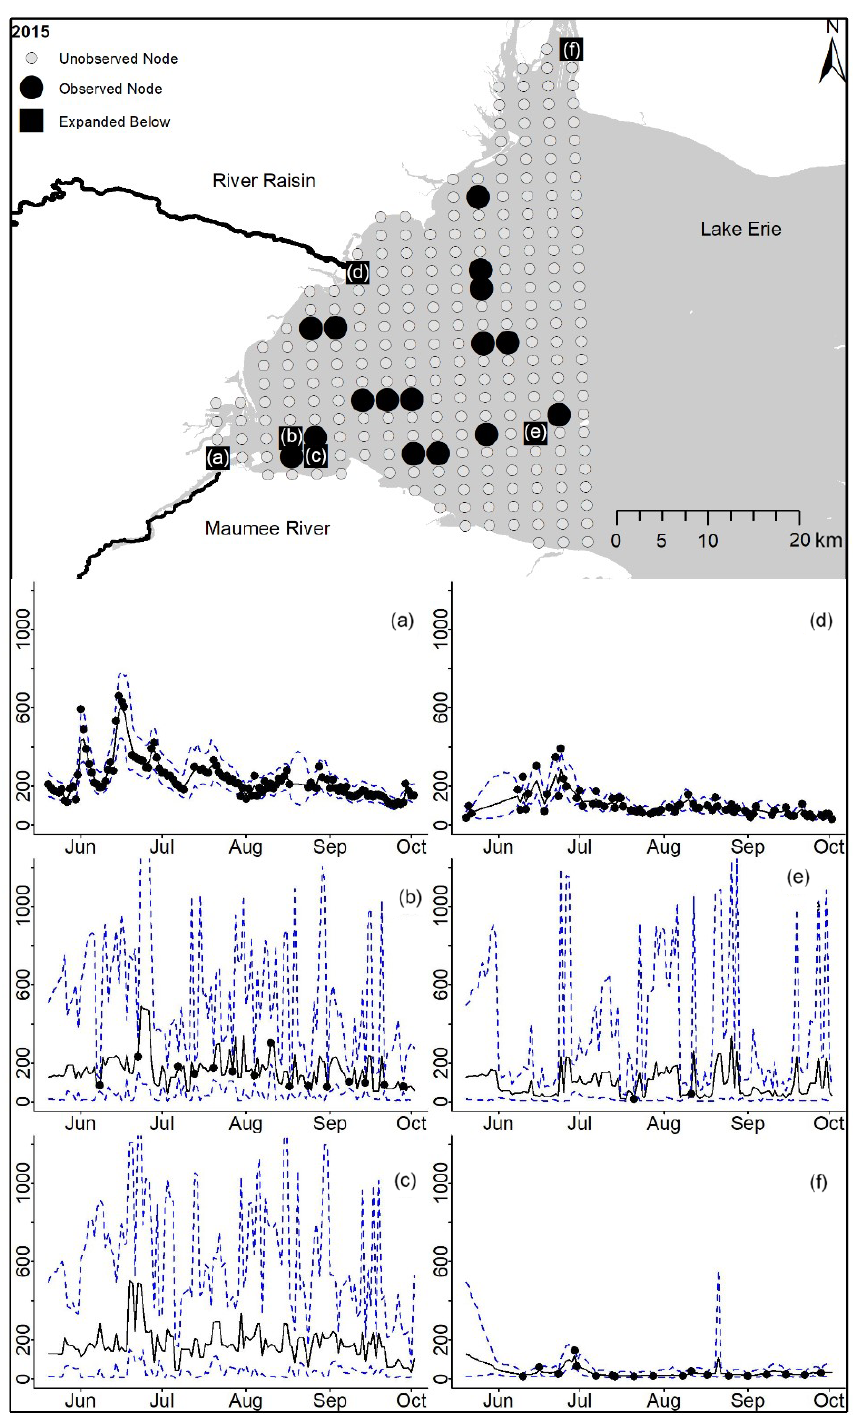
Figure D8. For 2015 the total phosphorus concentrations (µgL − 1 ) at observed and unobserved nodes were estimated from the model posterior samples. Mean (solid black line) and 95%PI (dashed blue line) for the model posterior samples of each node at every day for (a) the Maumee River, (b, c, e, f) western Lake Erie nodes, and (d) the Raisin